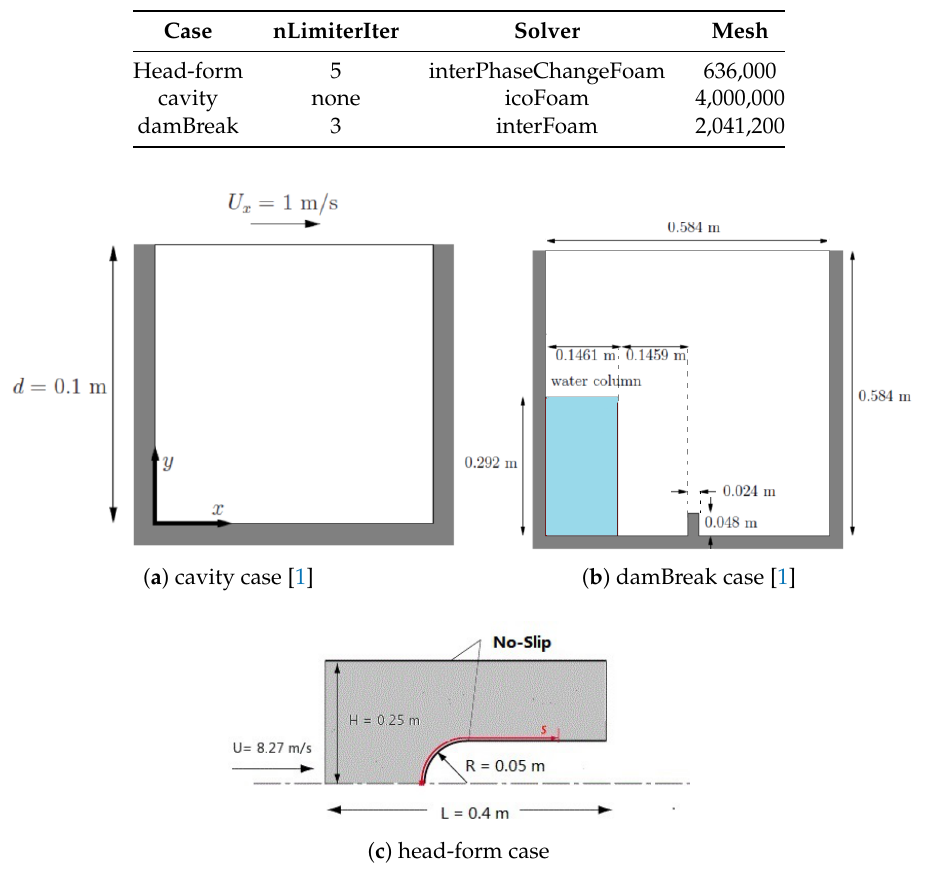
Figure 8. Geometric